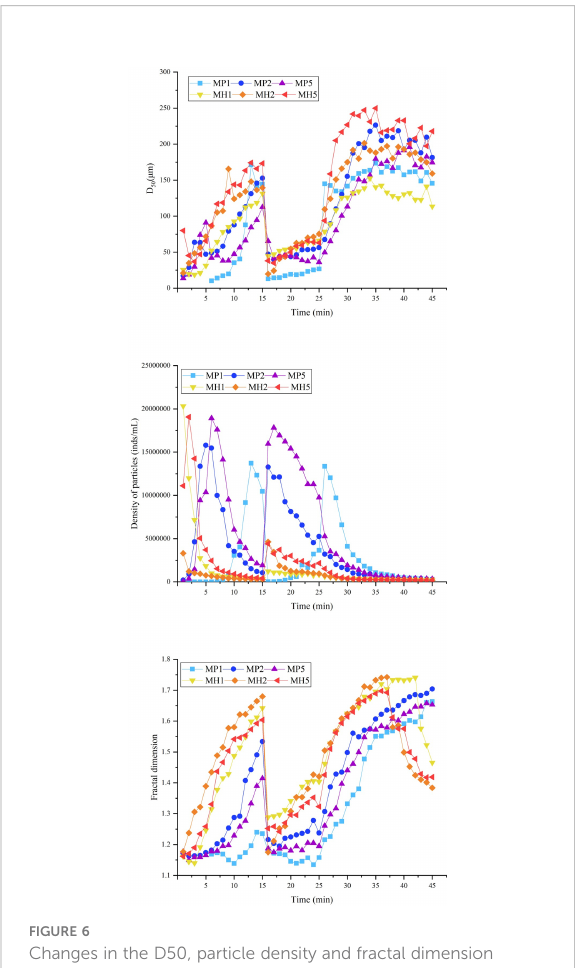
FIGURE 6 Changes in the D50, particle density and fractal dimension during self- fl occulation of modi fi ed clay under coagulation conditions.